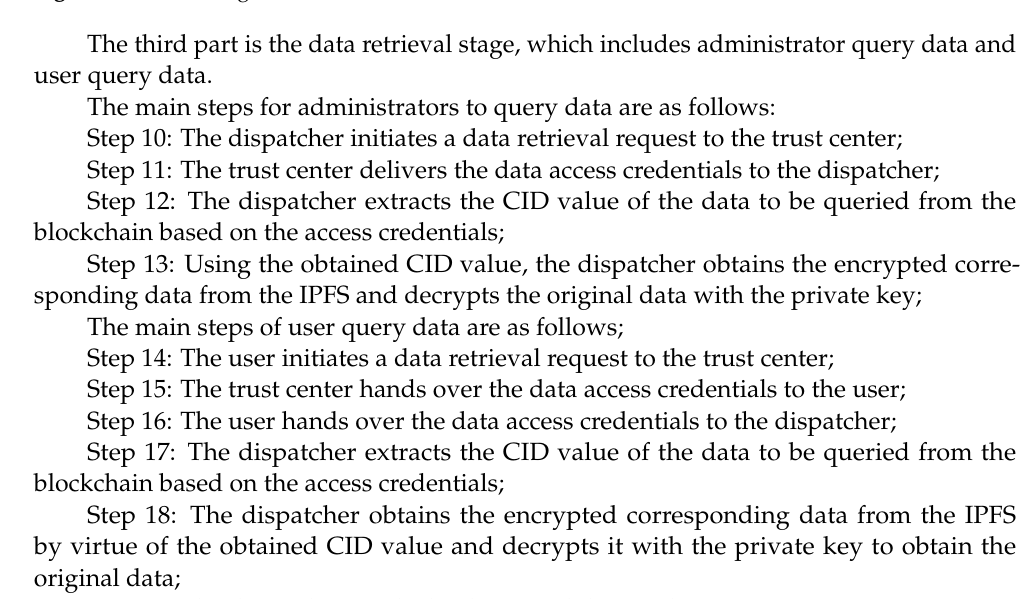
Figure 4. Data management model architecture based on the blockchain.